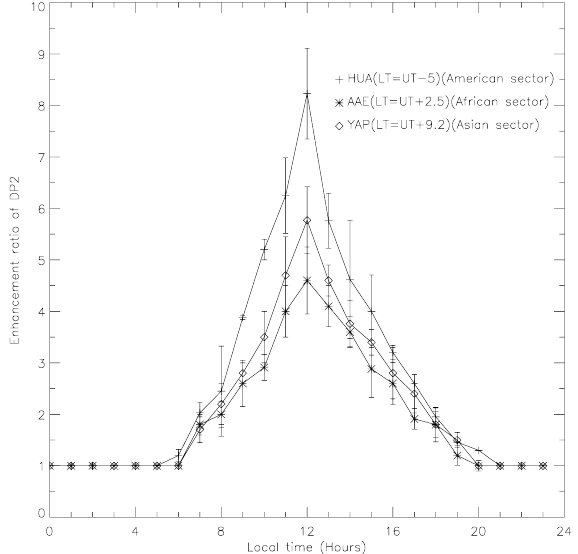
Fig. 8. Regular variation of H-component ( S r (H) ) average of 1998 over the American (HUA), African (AAE) and Asian sectors